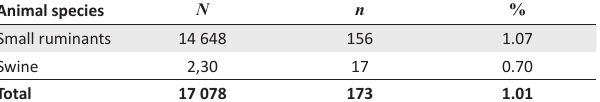
TABLE 1: Frequency of suspicious lesions in small ruminants and pigs slaughtered at the Bobo-Dioulasso abattoir from August to December 2017. Animal species N n %